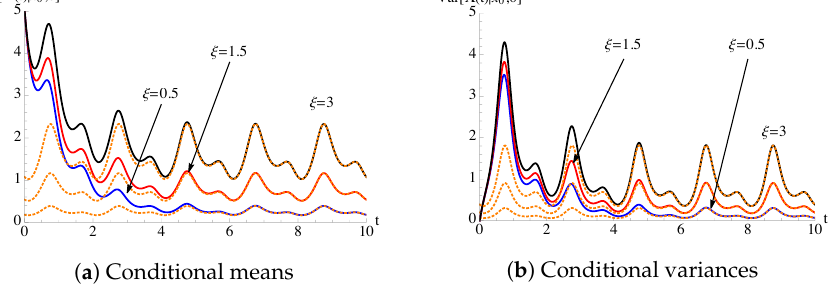
Figure 12. For the process (57), with x 0 = 5, ξ = 1.5, η = − 1, α ( t ) = η − 0.4 π cos (cid:0) (cid:1)(cid:3) − 1 0.2 sin 2 π t and r ( t ) = 0.5 functions indicate the related asymptotic densities.